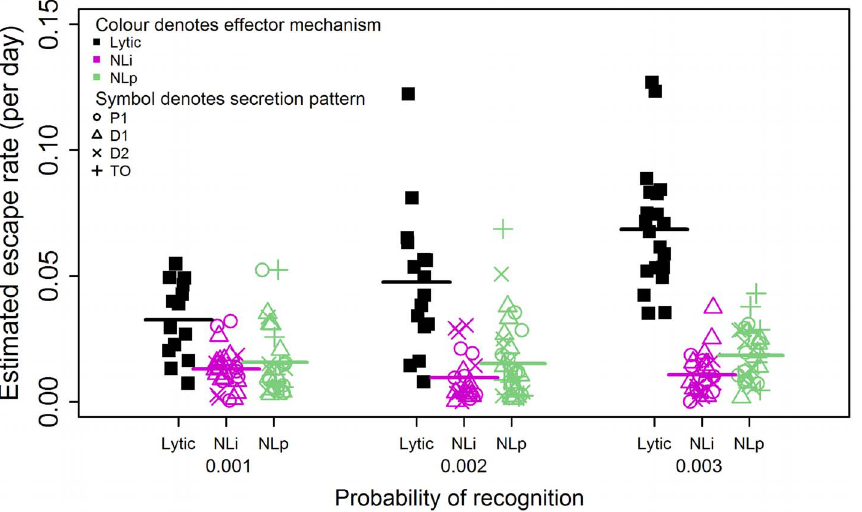
Figure 2. Non-lytic CD8 + T cells reproducibly drive viral escape but escape is slower than that driven by lytic CD8 + T cells. This was observed both for non-lytic factors that reduce infection and non-lytic factors that reduce production; for the three different probabilities of target cell recognition considered and for all secretion patterns considered. Abbreviations: NLi: Non-lytic model - reducing infection of uninfected CD4 + T cells, NLp: Non-lytic model - reducing virion production, TO: target cell only affected, P1: Polarised secretion (r=1), D1: Diffusive secretion (r=1) and D2: Diffusive secretion (r=2). Different colours represent different effector mechanisms (black: lytic, pink: NLi, green: NLp) and different symbols represent different patterns of secretion (open circle: P1, open triangle: D1, x: D2, cross:TO). The horizontal bars represent the mean. Lytic CD8 + T cells drive escape significantly faster and more frequently than CD8 + T cells operating via a non-lytic mechanism which impairs viral infection or a non-lytic mechanism that impairs virion production. Mean rates of escape from lytic CD8 + T cells: 0.033 d 2 1 , 0.048 d 2 1 , 0.069 d 2 1 for Pr=0.001, Pr=0.002, Pr=0.003 respectively. Mean rates of escape from non-lytic CD8 + T cells that impair infection: 0.013 d 2 1 , 0.010 d 2 1 , 0.011 d 2 1 for Pr=0.001, Pr=0.002, Pr=0.003 respectively. Mean rates of escape from non-lytic CD8 + T cells that impair virion production: 0.016 d 2 1 , 0.015 d 2 1 , 0.018 d 2 1 for Pr=0.001, Pr=0.002, Pr=0.003 respectively. In every case the difference between lytic and non-lytic escape rates is significant (P , 0.001, Wilcoxon Mann Whitney test two-tailed). The frequency of fixation is given in Table 1.